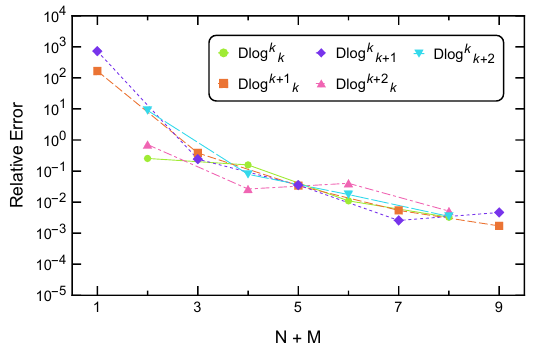
Figure 1. Relative error of the first predicted coefficient from D-log Padé approximants applied to the Borel transform of Π 00 ( s ) . Results for Dlog M as a function of N + M